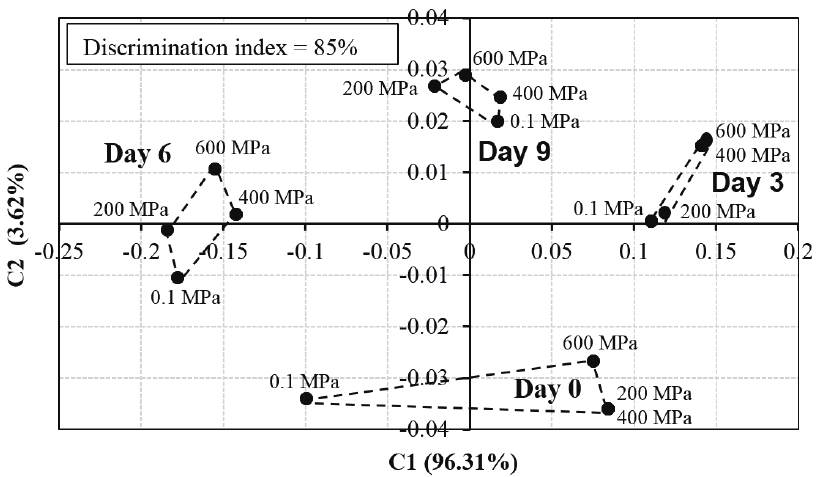
Figure 4. Principle component analysis of aroma pattern revealed by electronic nose for DFD beef strip loin subjected to different levels of pressure during refrigerated storage under vacuum. DFD,